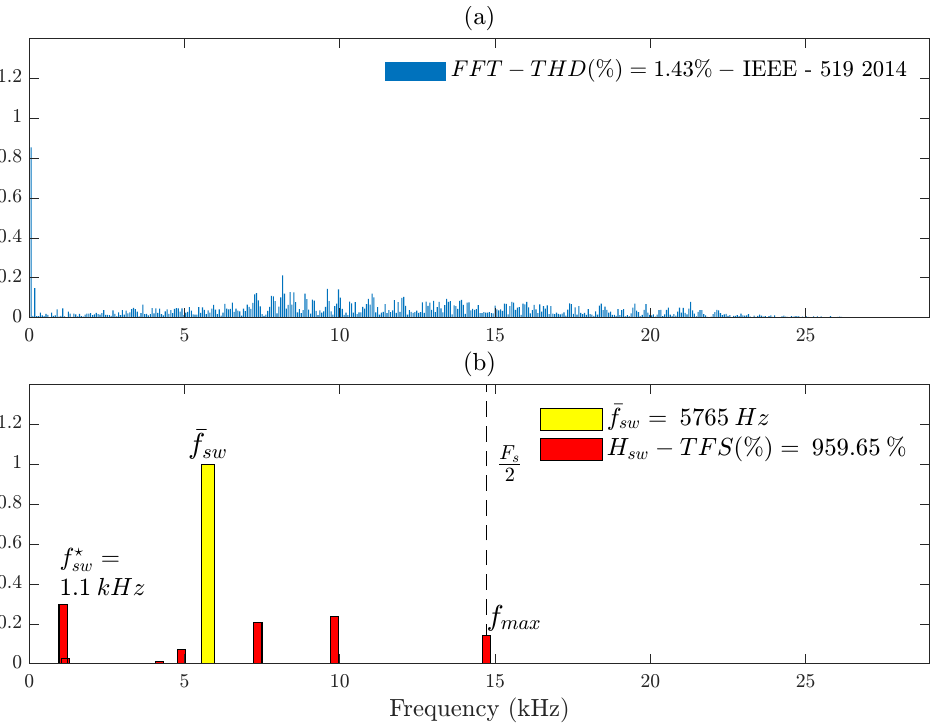
Figure 7. FCS-MPC-based converter with sampling frequency equal to 29,460 Hz ( F s = 491 × 60 Hz): ( a ) FFT of the switching pulses and ( b ) switching frequency components ( H sw ) obtained by Algorithm